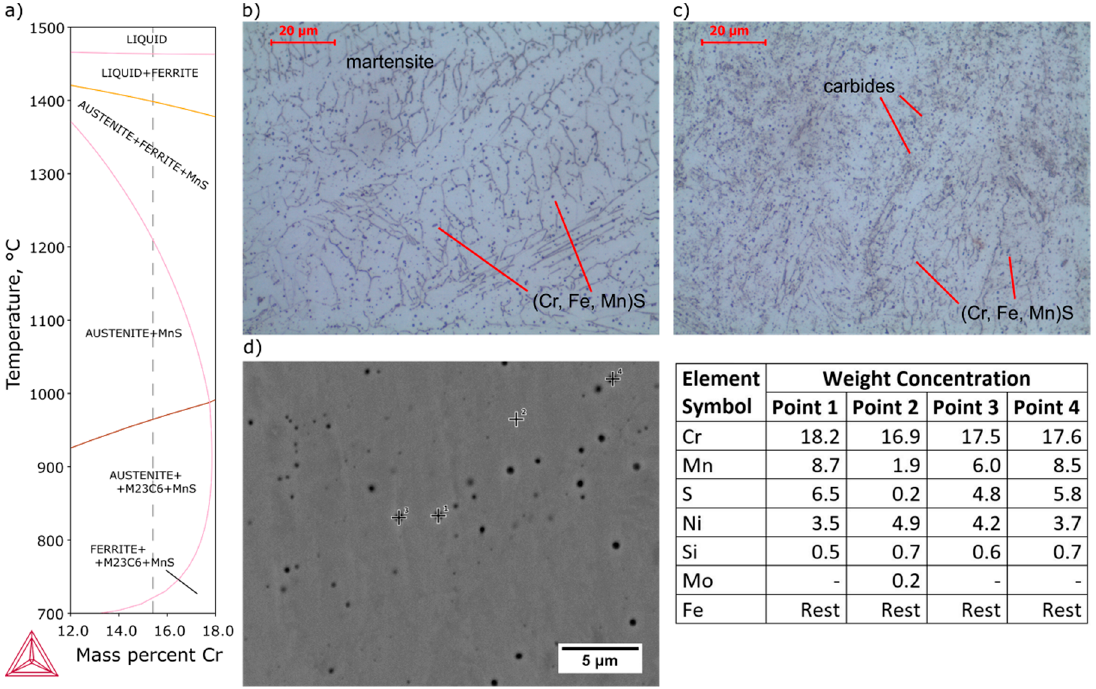
Figure 8. Microstructure and EDS point analysis of weld metal: ( a ) pseudobinary phase diagram of 0.11C-0.7Si-1.9Mn-0.2S-0.4Mo-4.5Ni steel, ( b ), ( c ) microstructure (Kalling’s + CrO 3 etched), ( d ) SEM microstructure and EDS points analysis (polished).